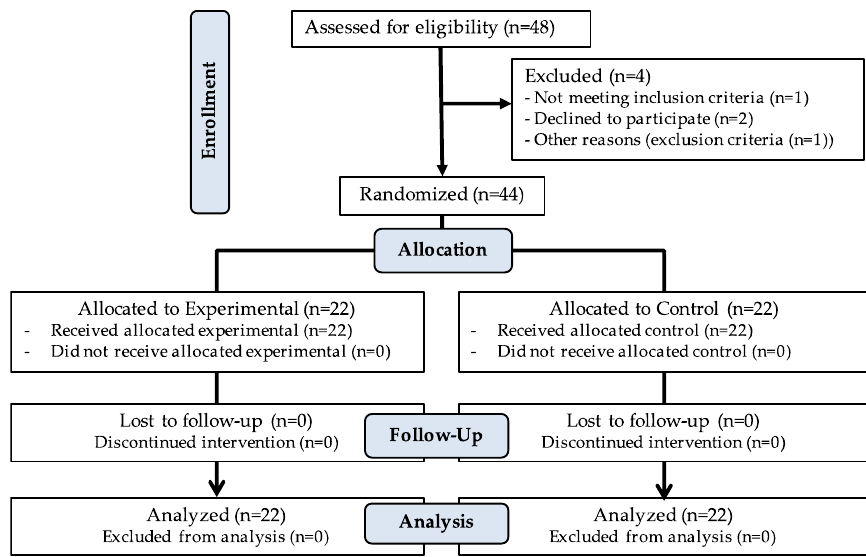
Figure 1. CONSORT flow diagram.